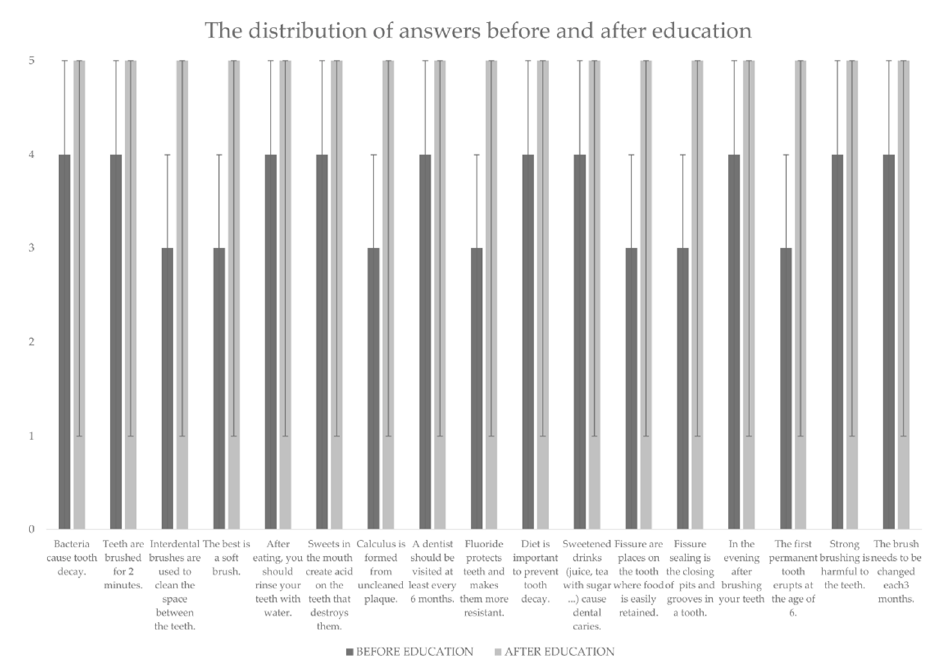
Figure 1. The distribution of answers before and after education. (Statistical significance was observed on each question). Table 2. The distribution of answers after education, observing three forms of teaching (video, lecture, and pamphlet). Video